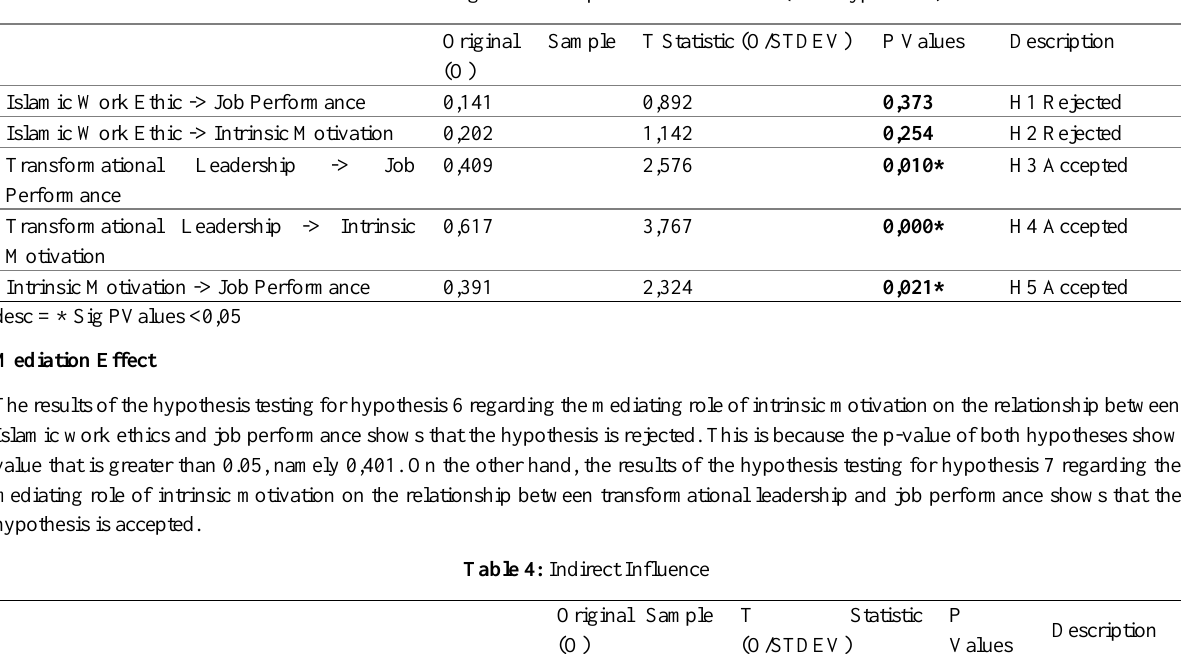
Table 3: Results of Testing Relationship Between Construct (Test Hypothesis)